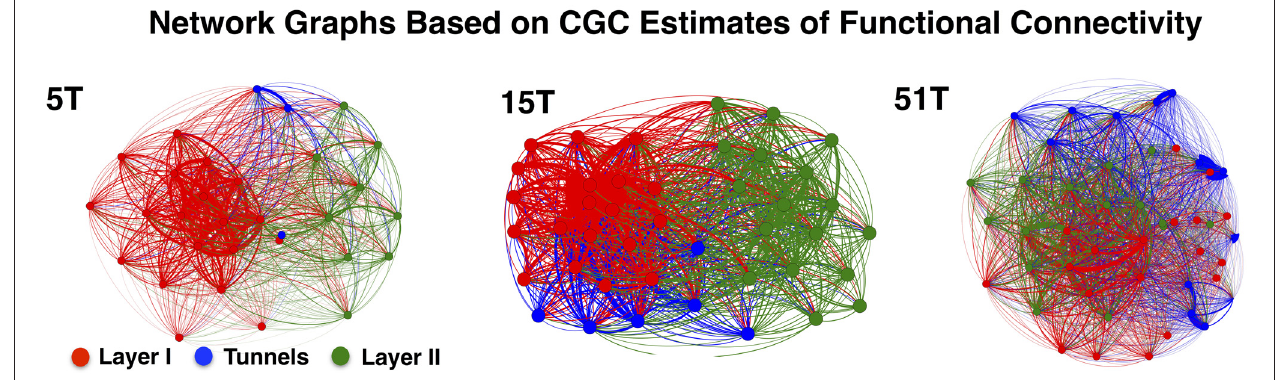
FIGURE 4 | Network graphs depicting functional connectivity based on CGC causal strength . Network graphs of three representative cultures from Groups 5T, 15T, and 51T. Each node denotes an electrode and each is colored according to the electrodes original location (Red denotes electrodes in Layer I, Green in Layer II while Blue for Tunnel data). The network layout was computed using a spring-mass (Force-directed) mapping to illustrate the difference in the functional connectivity between the coupled networks in each group. The numbers of tunnels between layers play a vital role in the modularity of the network (i.e., the number of connections a node in a single layer has with other nodes within across the layers) producing unique clusters representing each layer. These clusters begin to merge as the number of tunnels increase permitting greater connectivity and coupling between